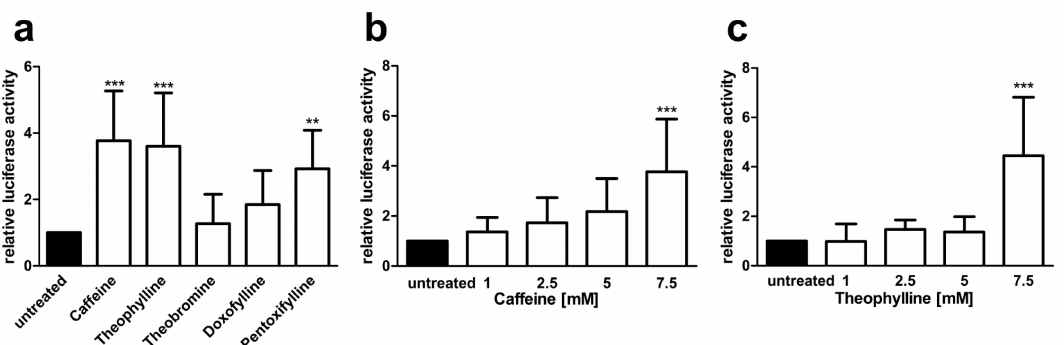
Figure 7. AGA -luciferase minigene splicing assays in patient fibroblasts ( a – c ) Patient fibroblasts were transfected with the AGA -luciferase minigene construct and treated with ( a ) 7.5 mM of substances or ( b ) increasing amounts of caffeine or ( c ) theophylline for 24 h. Relative luciferase activity of the untreated samples was set as 1. Bars represent the mean ± SD of at least five independent experiments, statistics with one-way ANOVA against the untreated samples. Values of p < 0.01 were considered very significant (**) and p < 0.001 extremely significant